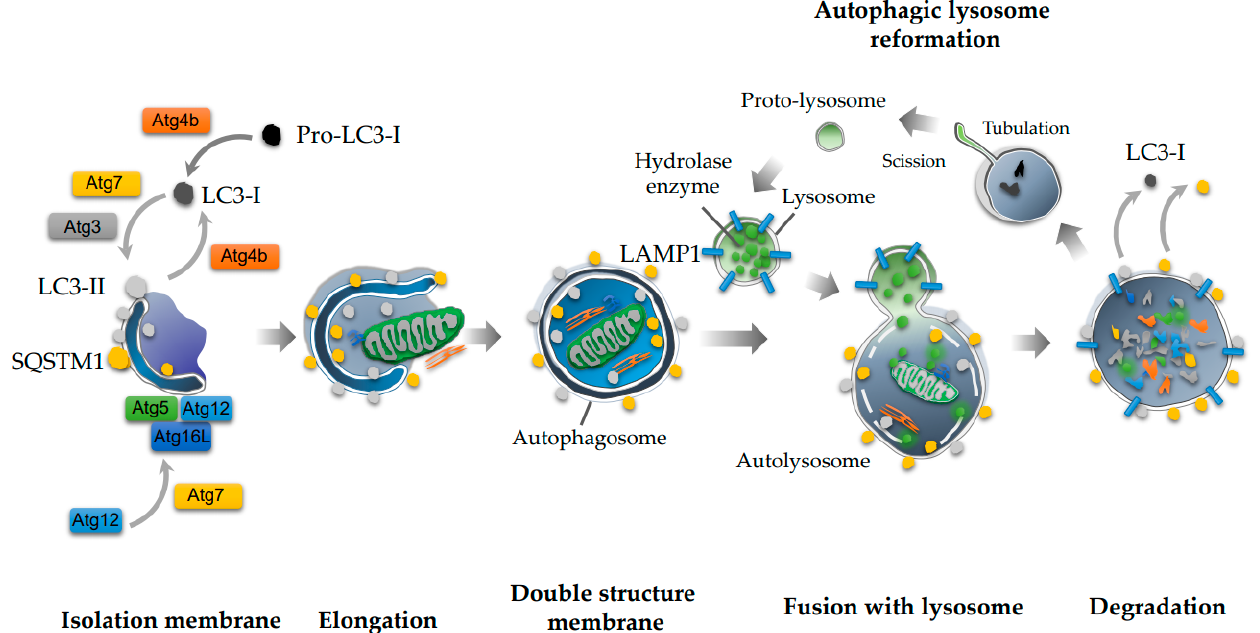
Figure 1. Autophagy cascade. Microtubule-associated protein 1 light chain 3 (LC3-I), which is generated from pro-LC3-I by Atg4B, is converted to LC3-II by Atg7 and Atg4B. Atg4B also mediates the conversion of LC3-II to LC3-I. An isolation membrane is elongated with LC3-II and Atg5-Atg12-Atg16L complex. The isolation membranes are closed, resulting in the autophagosome. Subsequently, the autophagosome fuses with lysosome, in which LAMP1 is expressed in the membrane, and digests the contents of the inner membrane. Lysosomes are also generated from the autolysosome by a recycling of protolysosomal membrane components.